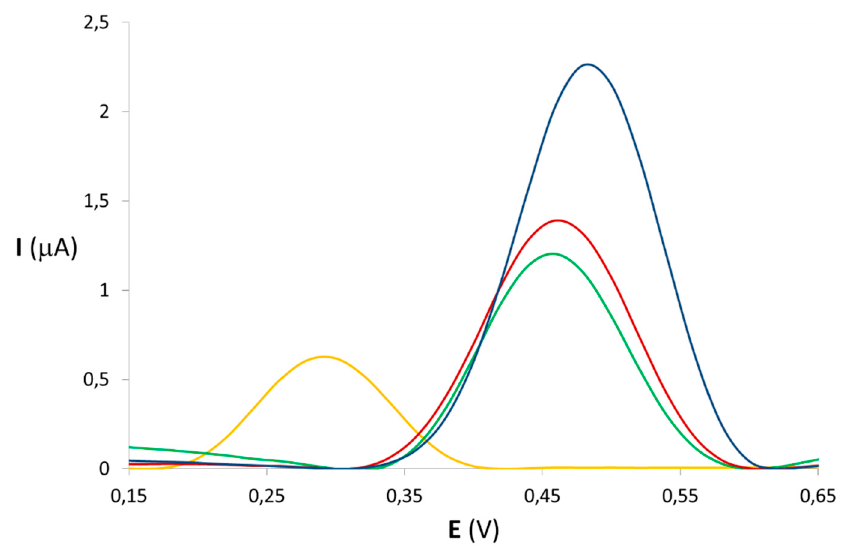
Figure 2. Di ff erential pulse voltammograms for 12 (25 µ M, green), 13 (12.5 µ M, red), 14 (6.25 µ M, Figure 2. Differential pulse voltammograms for 12 (25 µM, green), 13 (12.5 µM, red), 14 (6.25 µM, blue), and 18 (50 µ M, orange) in 10 mM phosphate bu ff er at pH 7.2 and 25 ◦ C with 20 mM NaCl as the blue), and 18 (50 µM, orange) in 10 mM phosphate buffer at pH 7.2 and 25 °C with 20 mM NaCl as supporting electrolyte. the supporting electrolyte. Table 1. Oxidation potential ( E p ) and current intensity ( I p ) of di ff erential pulse voltammetry (DPV) Table 1. Oxidation potential ( E p ) and current intensity ( I p ) of differential pulse voltammetry (DPV) peaks for 18 , and 12 – 14 in 10 mM phosphate bu ff er at pH 7.2 and 25 ◦ C with 20 mM NaCl. peaks for 18 , and 12 – 14 in 10 mM phosphate buffer at pH 7.2 and 25 °C with 20 mM NaCl. Compound Concentration (µM)